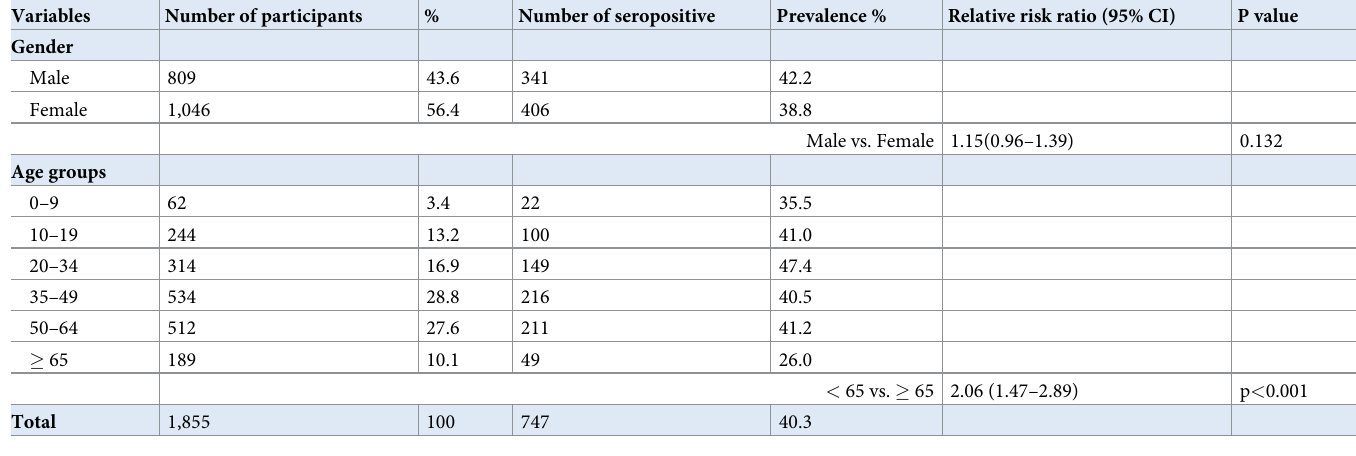
Table 1. Distribution and prevalence of seropositive participants according to gender and age groups.